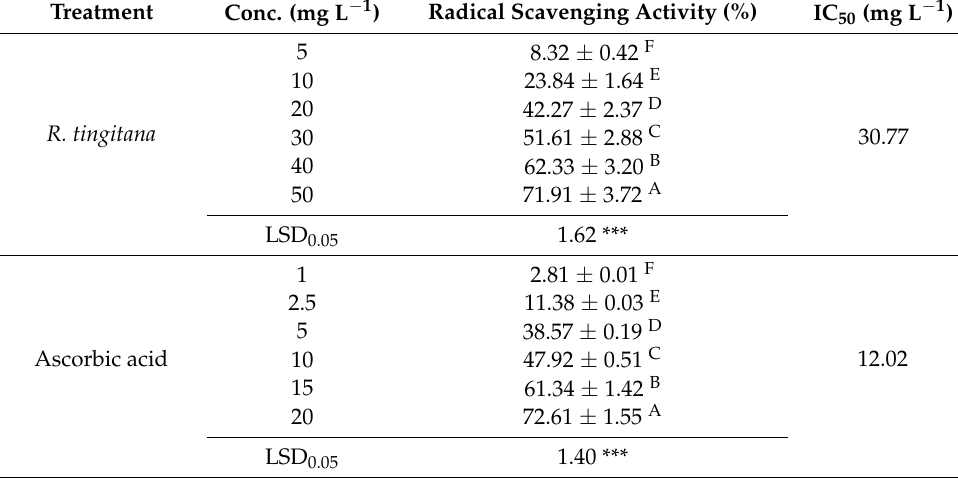
Table 2. Radical scavenging activity percent (%), and IC 50 values (mgL −1 ) at various concentrations of the methanol extracted of R. tingitana and the standard ascorbic acid by DPPH assay. Treatment Conc. (mg/L)